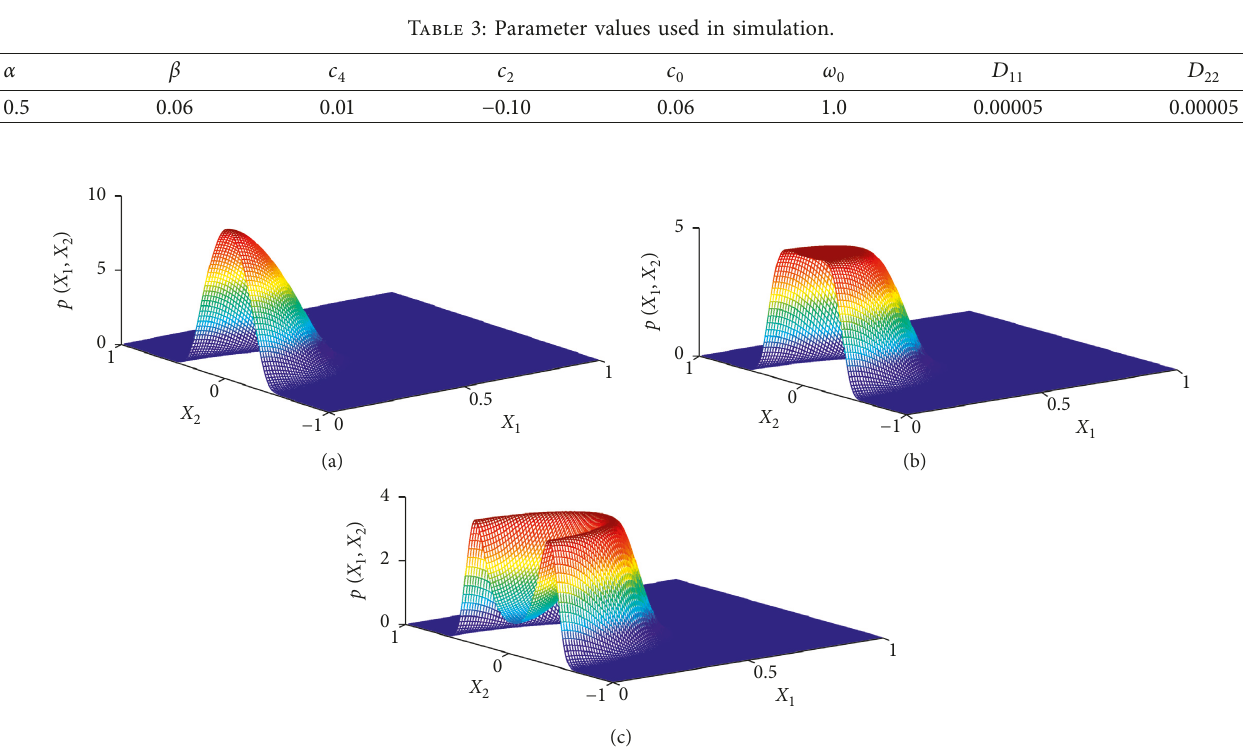
Figure 3: The joint probability density functions for different r . (a) r � 0 . 984. (b) r � 0 . 986. (c) r � 0 .